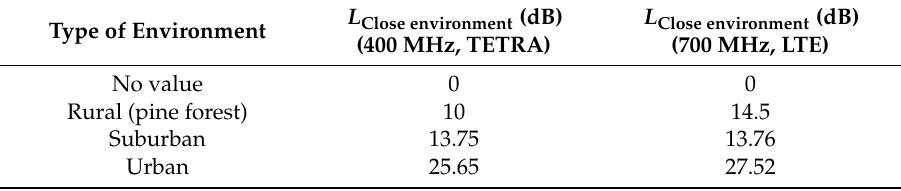
Table 1. Obtained path loss for the different types of environments